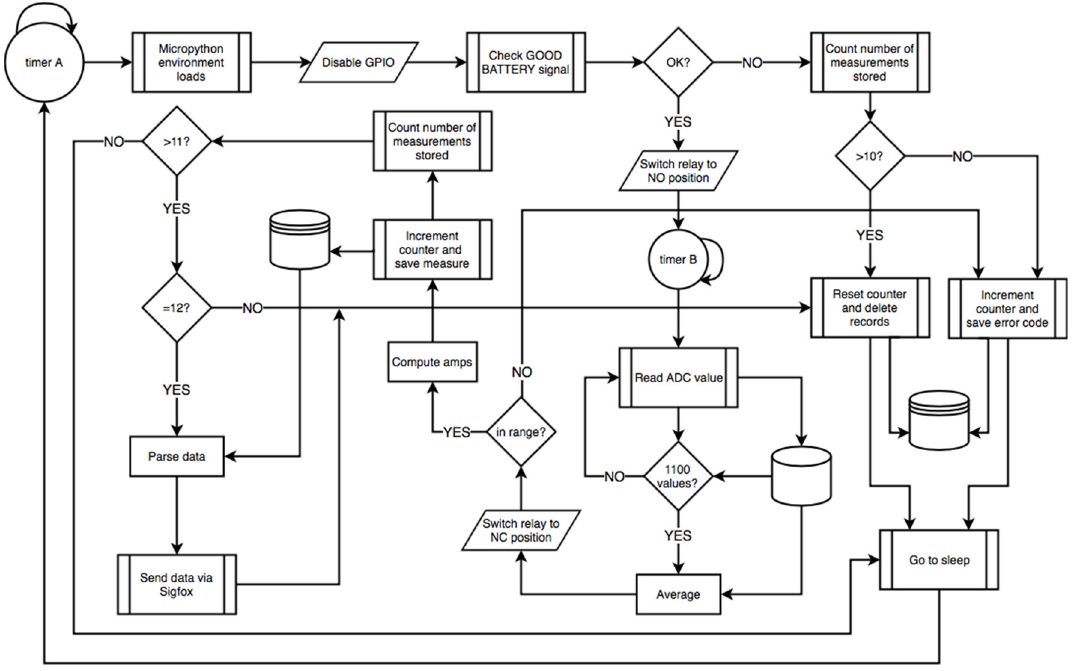
Figure 11. Flowchart for the microcontroller’s (MCU) firmware.